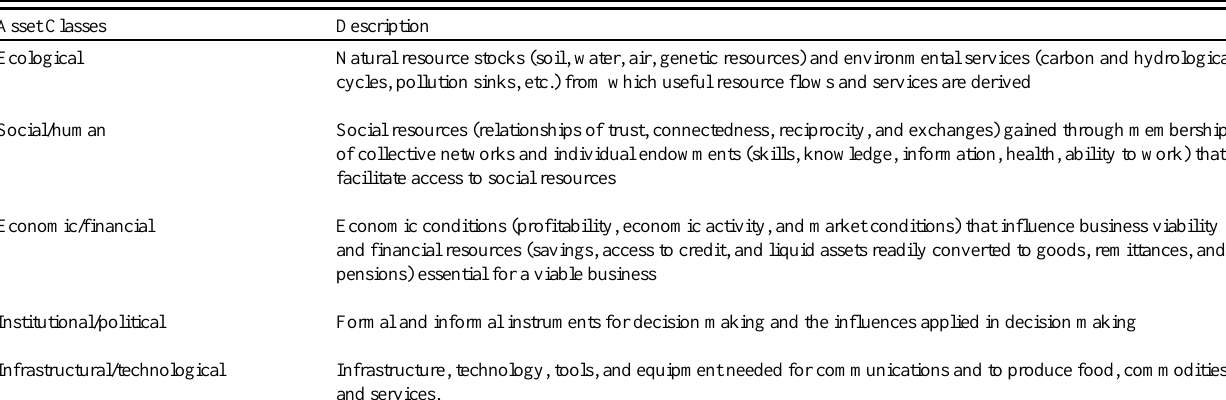
Table 3 . Description of asset classes relevant to marine sectors (adapted in part from Scoones